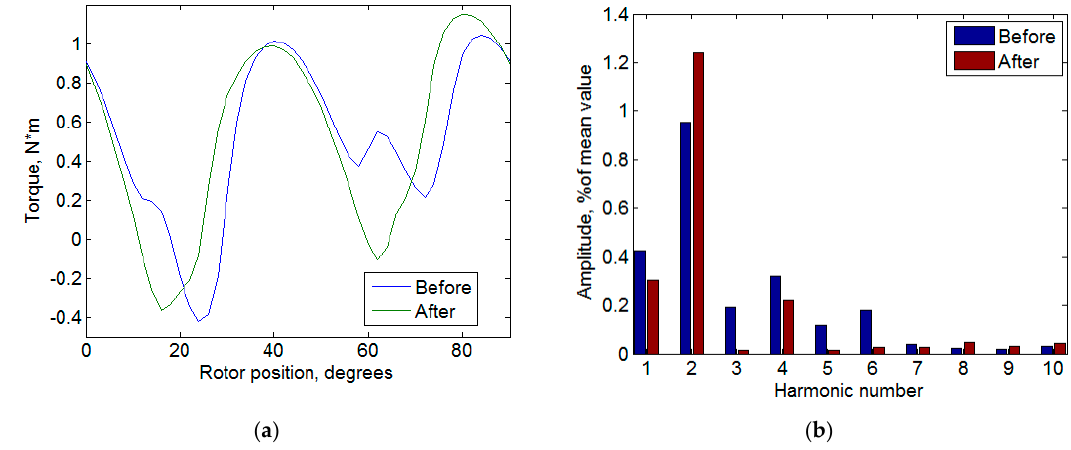
Figure 8. ( a ) The single-phase FRMs’ torque ripple; ( b ) its Fourier spectrum.